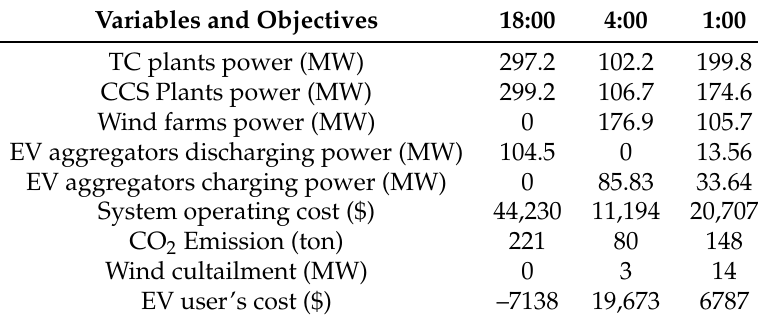
Table 3. Best compromised solutions at different times.